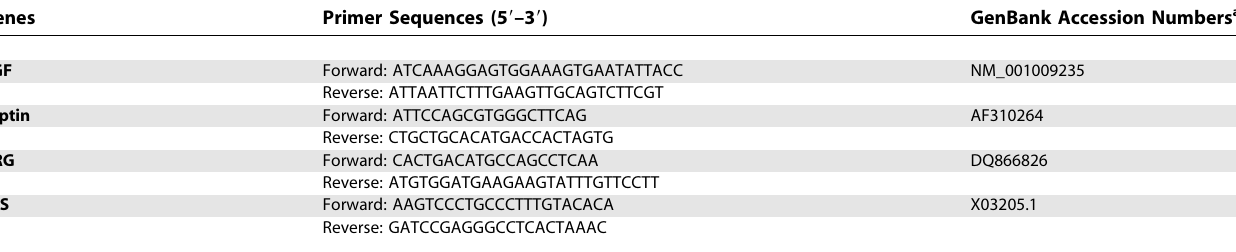
Table 3. Primer Sequences for Real-Time